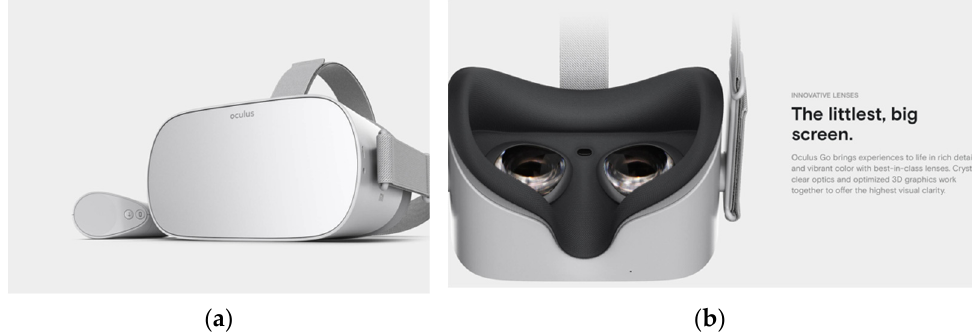
Figure 1. Sample individual virtual-reality headset ( a ) front and ( b ) user interface.